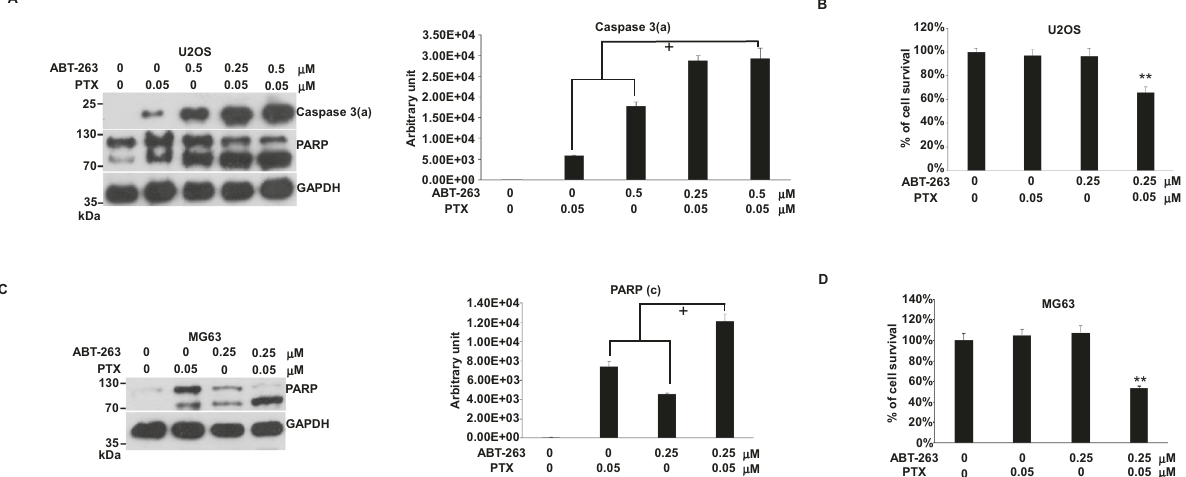
Fig. 6 Effects of the combination of PTX with ABT-263 on apoptosis in U2OS and MG63 cells. Cells were incubated with ABT-263, PTX, or a combination of both in 10-cm plates or 96-well plates for 24 h and harvested for western blotting or cell death assay, respectively. The immunoblot images of caspase 3(a) and PARP and cell death results were shown. GAPDH served as a loading control. The immunoblot images of caspase 3(a) or PARP normalized to GAPDH in cells were quantitated as shown. The “ + ” indicated an additive outcome. The percentages of cell survival normalized to the cells without compound treatment were shown (** P < 0.01). Immune blots were cropped from different parts of the same gels and visualized by ECL with various exposure conditions dependent on the activity of antibodies. Representative blots from triplicate experiments were shown. A Immunoblot image of U2OS. B U2OS cell survival. C Immunoblot image of MG63. D MG63 cell